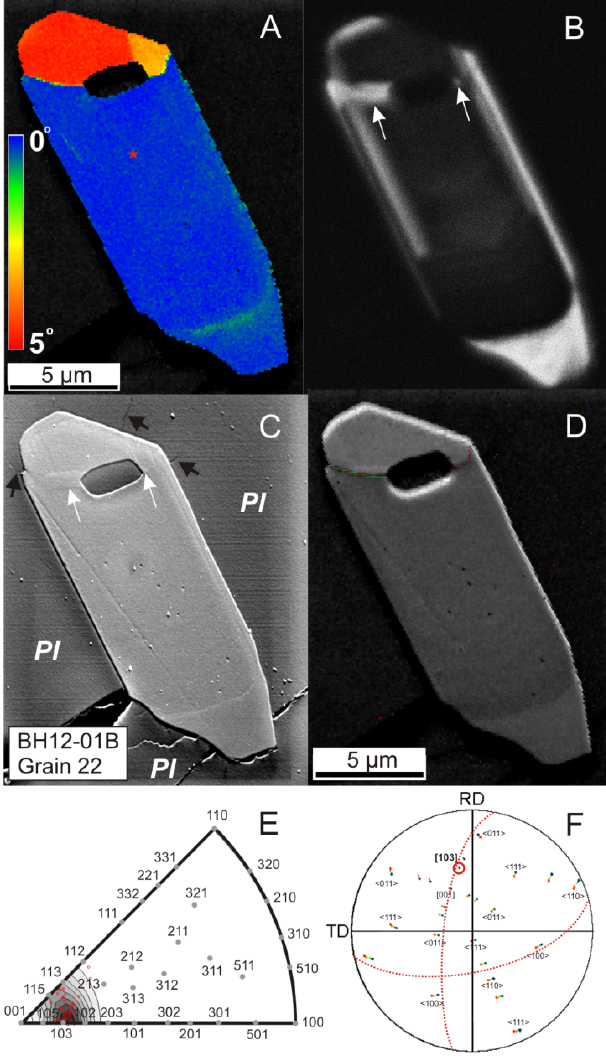
Figure 6. Grain BH12-01B_22 lattice distortion type (III) case 3. (a) EBSD map color-coded for misorientation with respect to a ref- erence point (red star marker). (b) CL image with bright recrys- tallization zones (shown by white arrows). (c) SE image showing subtle fractures (black arrows) in host plagioclase, and recrystal- lization zones as in (b) (shown by white arrows); Pl: plagioclase; (d) EBSD pattern quality map showing subgrain boundaries col- ored for misorientation angles between subgrains (red lines: 2–3 ◦ ; green lines: 3–5 ◦ ). (e) Inverse pole figure plot of the misorienta- tion axes distribution density showing concentration around zircon [103]. (f) Pole figure plot showing zircon crystal directions (lower- hemisphere equal area projection) colored as in (a) . Labels indicate the crystallographic directions. Orientation scattering corresponds to rotations around [103] (red circle). Dashed red lines show bound- ary wall